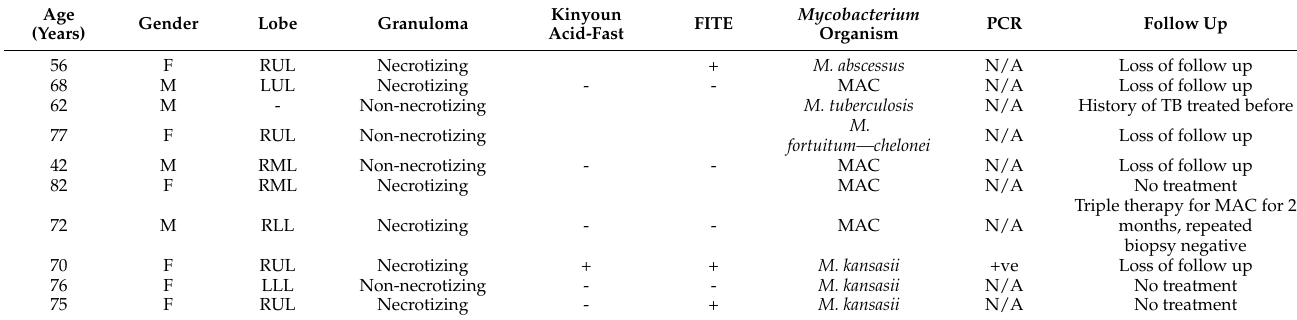
Table 5. Cases with positive lung tissue cultures for mycobacteria (10 patients).